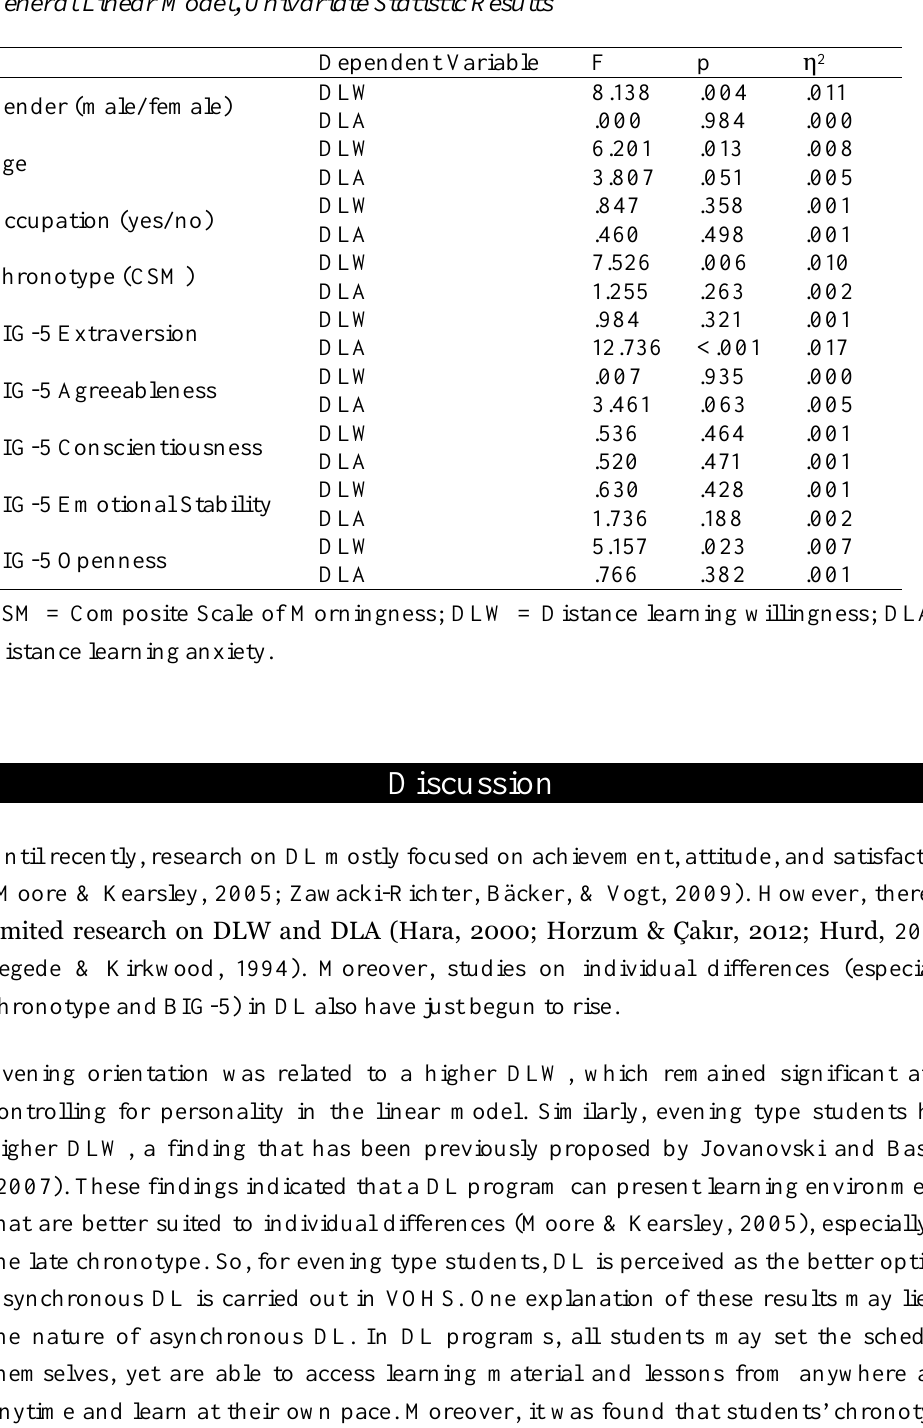
Table 2 General Linear Model, Univariate Statistic Results